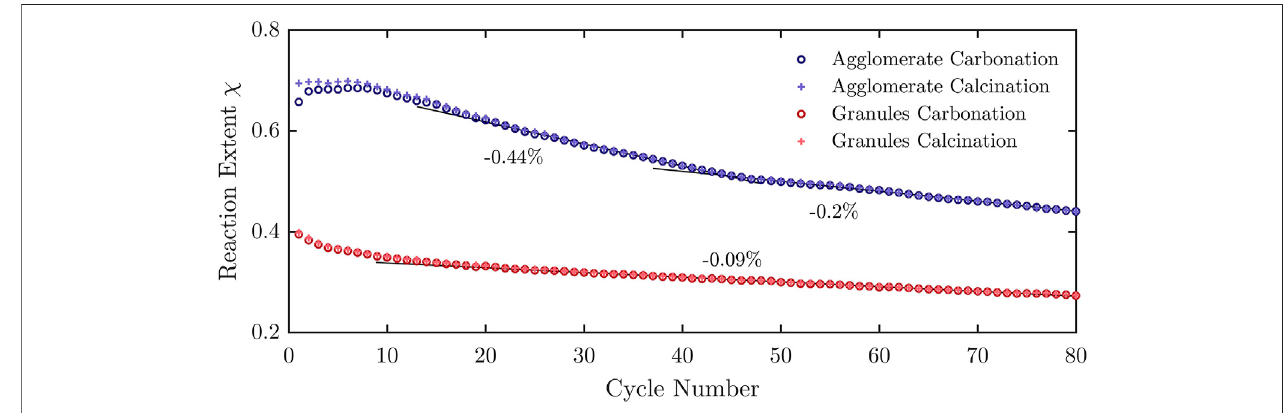
FIGURE 8 | Reaction extents for agglomerates and granules over 80 consecutive carbonation-calcination cycles, performed in the TCS reactor using a temperature-swing between 830 ° C and 930 ° C with dwell times of 93 min. Indicated is the linear degradation.